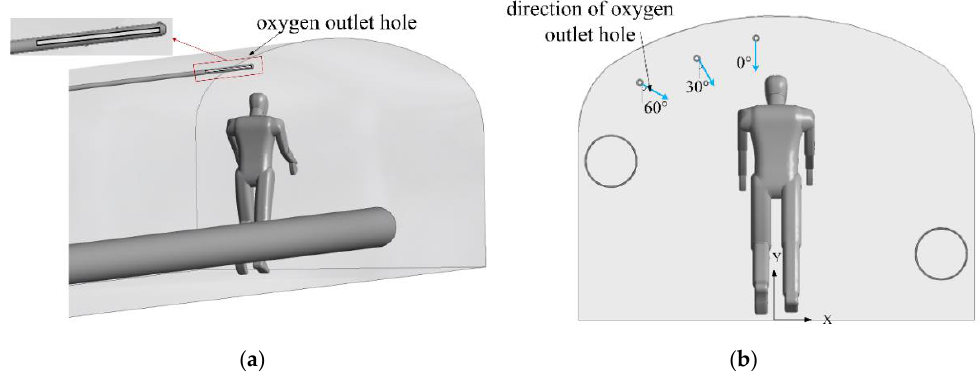
Figure 5. Layout scheme for the oxygen supply duct. ( a ) Outlet of oxygen supply duct; ( b ) directions of oxygen outlet holes. Table 3. Optimization scheme for the oxygen supply duct outlet.